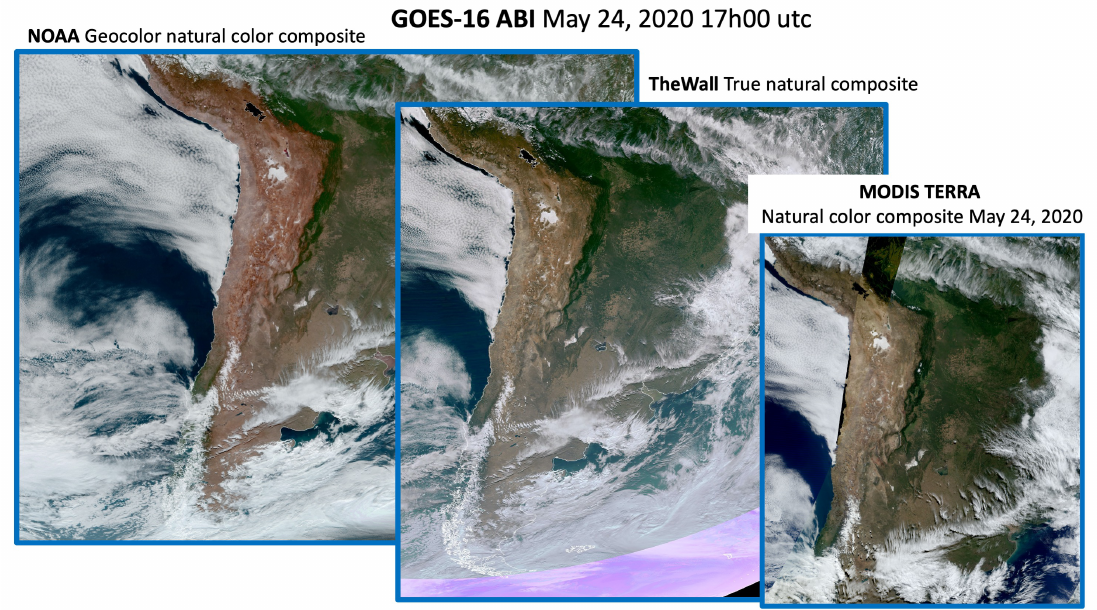
Figure 12. Comparison of our GOES-16 true natural color RGB composite to the GeoColor natural color composite and MODIS data, all taken over South America on 24 May